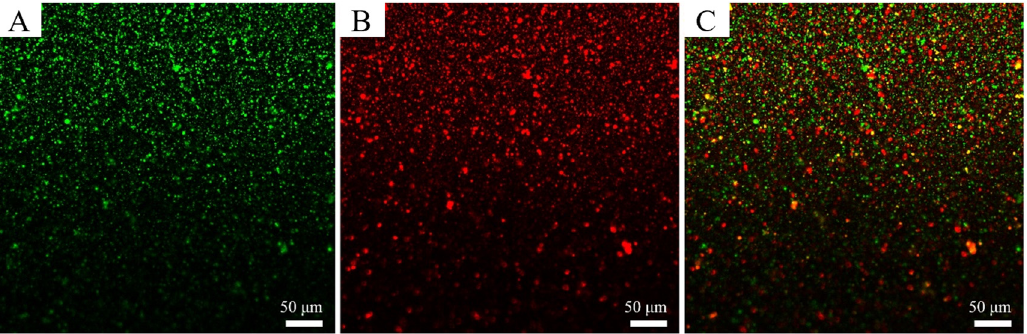
Figure 6. CLSM images of Z-R/P 2:1 particle-stabilized Pickering emulsions. Oil phase dyed with Nile red ( A ), Z-R/P 2:1 particles dyed with Nile blue ( B ), overlap image ( C ). FTIR is usually used to determine the interaction information between